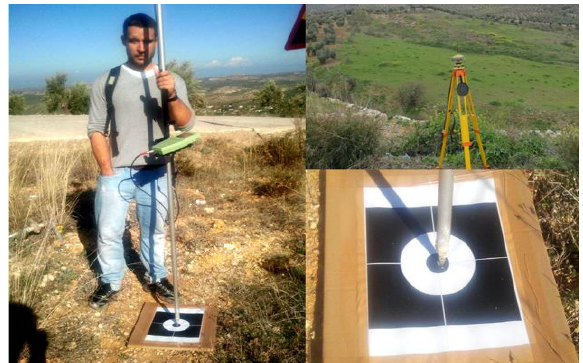
Figure 5. Measurement of control points using GPS positioning. From these GCP and some hundreds of automatically measured made through a process of triangulation and bundle block adjustment (Kraus, 2007) and Structure for Motion (SfM) techniques. Two digital photogrammetric stations, Photoscan Socet Set DPW (for DSM edition, orthophoto generation